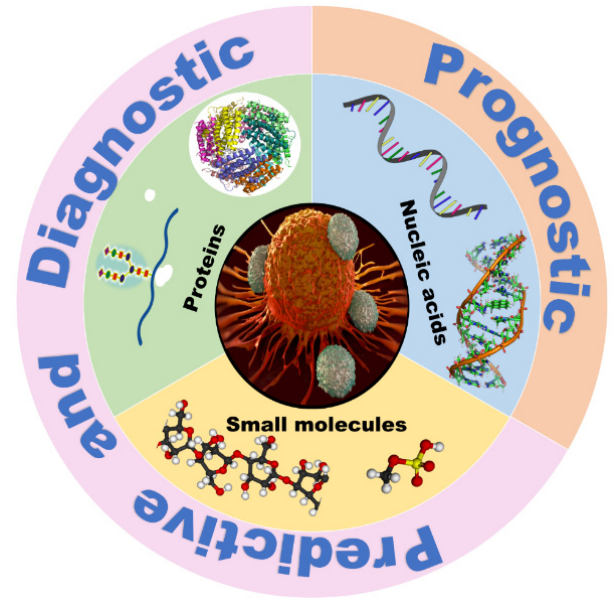
Figure 1. A simple overview of cancer biomarkers and their clinical importance.